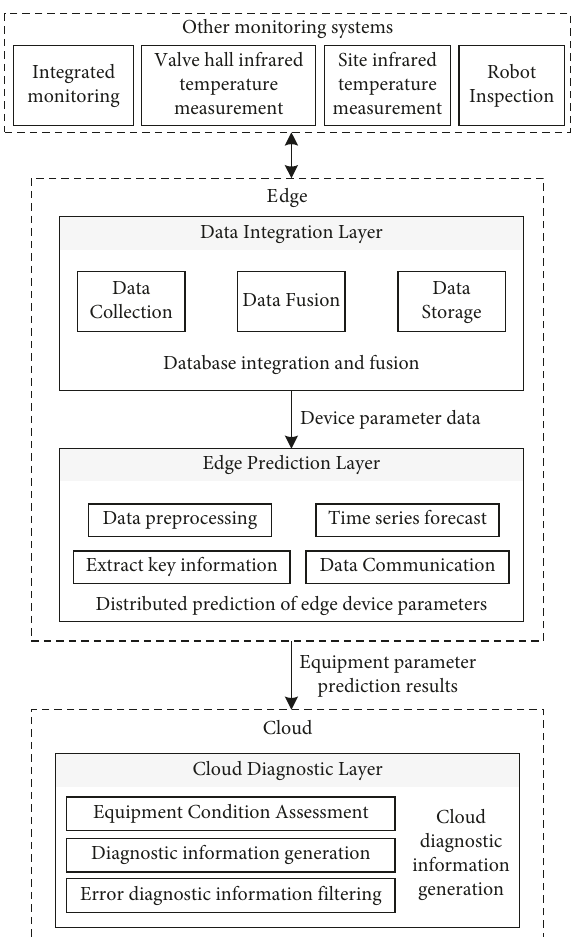
Figure 1: Four-layer hierarchical structure of fault diagnosis